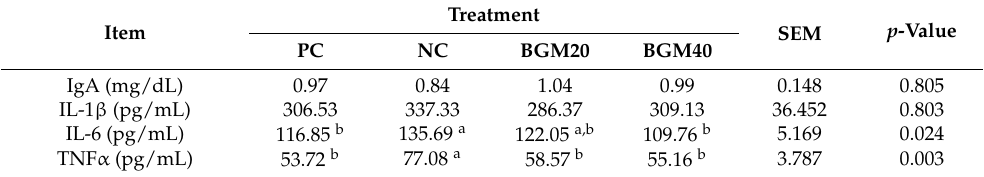
Table 5. Effect of dietary BGM with combined enzymes inclusion on the immunity of growing pigs 1